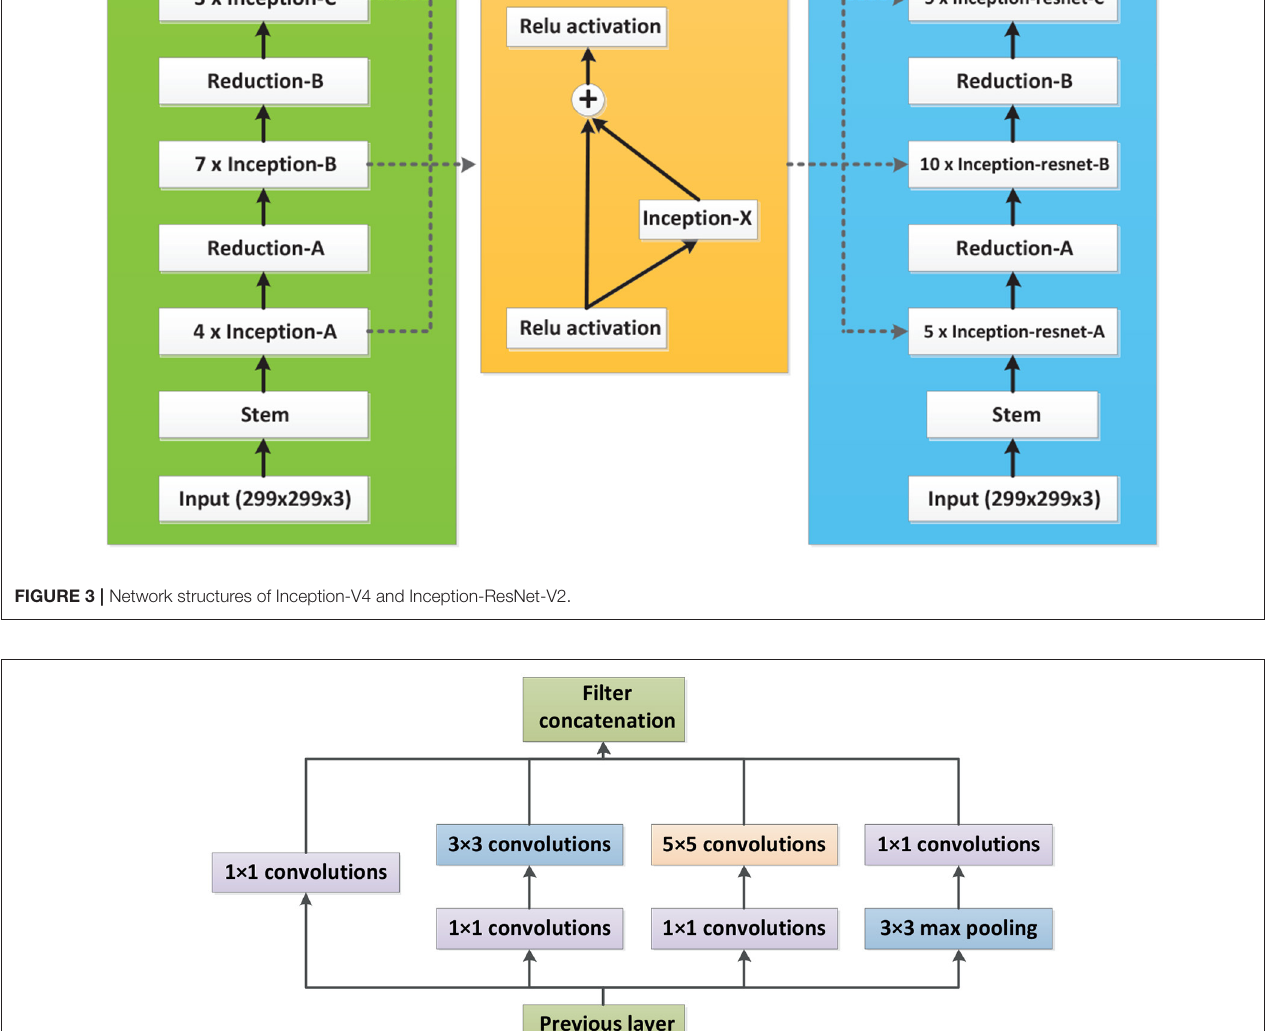
FIGURE 4 | Inception module.